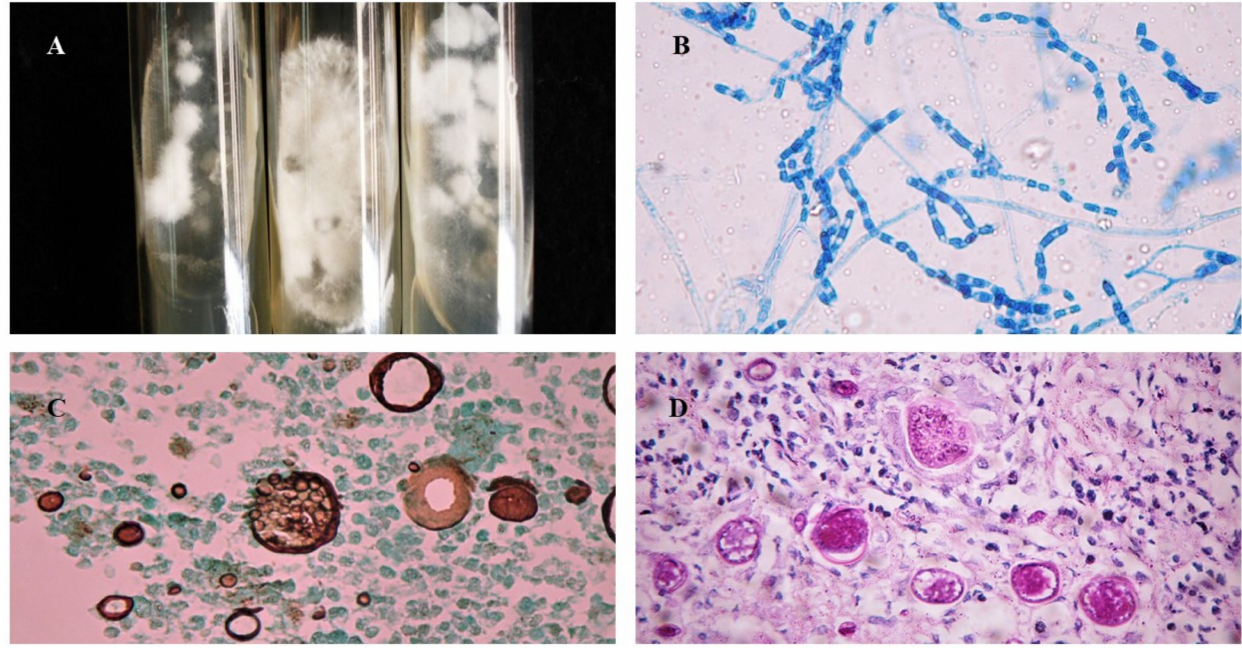
Figure 3. Morphological aspects of Coccidioides spp.: ( A ) Colonies of filamentous fungi in Sabouraud Dextrose Agar cultivated at 25 ◦ C after 2 weeks; ( B ) Arthroconidia and septate hyaline hyphae of Coccidioides at 25 ◦ C, stained with cotton blue, 40 × ; ( C ) Histopathological examination of biopsy stained with Grocott–Gomori methenamine-silver showing Coccidioides spp. spherules with multiple endospores, 40 × ; ( D ) Histopathological examination of biopsy stained with Periodic Acid Schiff showing Coccidioides spp. spherules, 40 ×